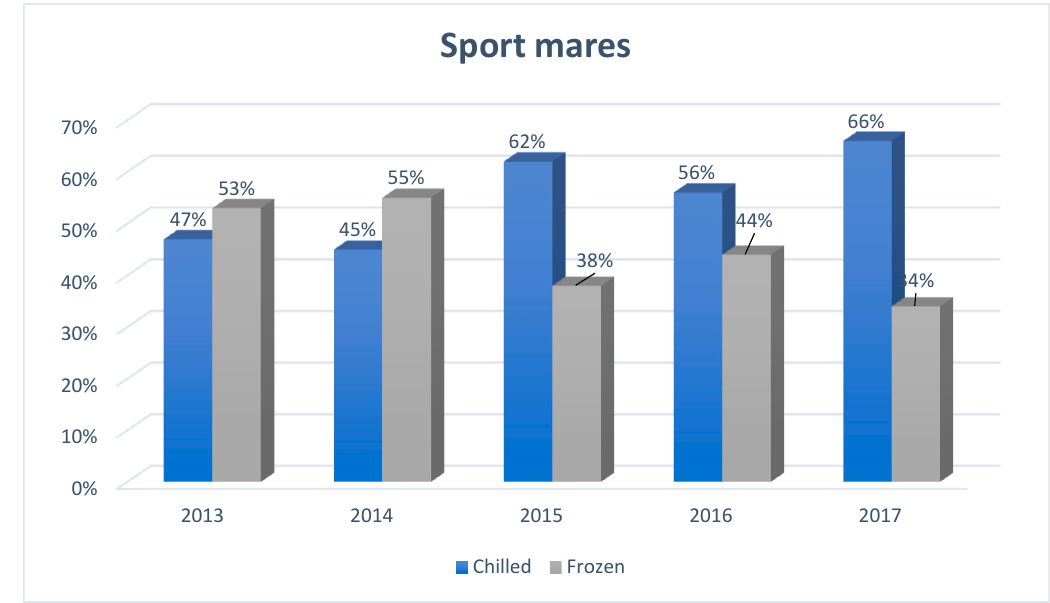
Figure 1. The structure of insemination of sport mares in Europe, including the division into the type of semen used for artificial insemination ( N = 2480), developed based on reports from European insemination stations.